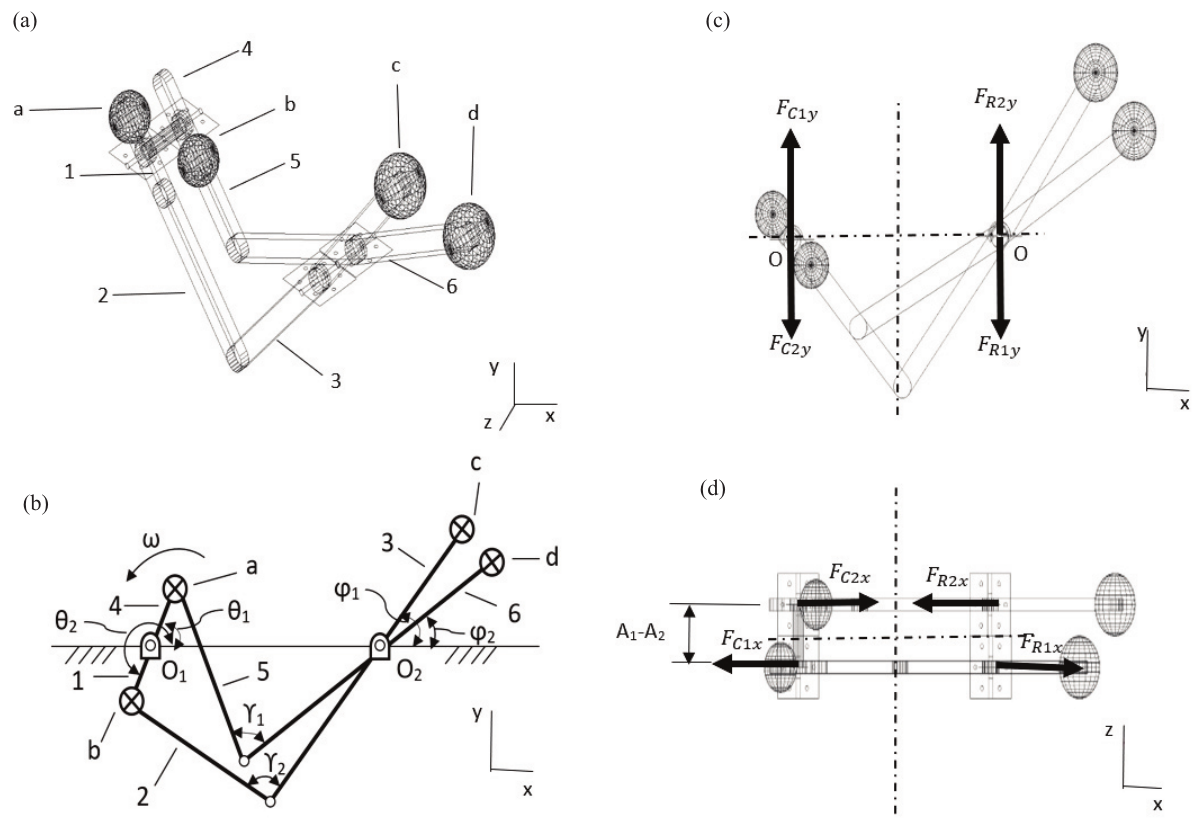
Fig. 1. Configuration and dynamic analysis of DCR mechanism: 3D configuration (a), kinematic scheme (b), plan view y­z (c), and plan view z­x